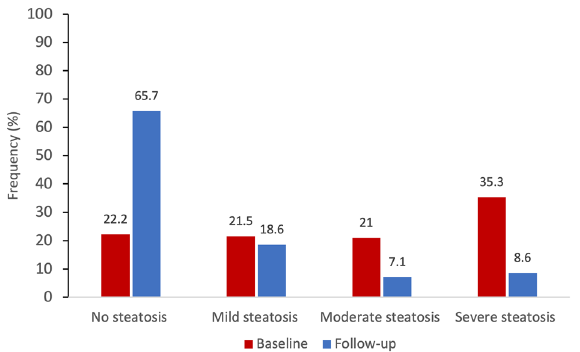
Figure 2. Comparison of CAP steatosis scores at baseline and follow-up